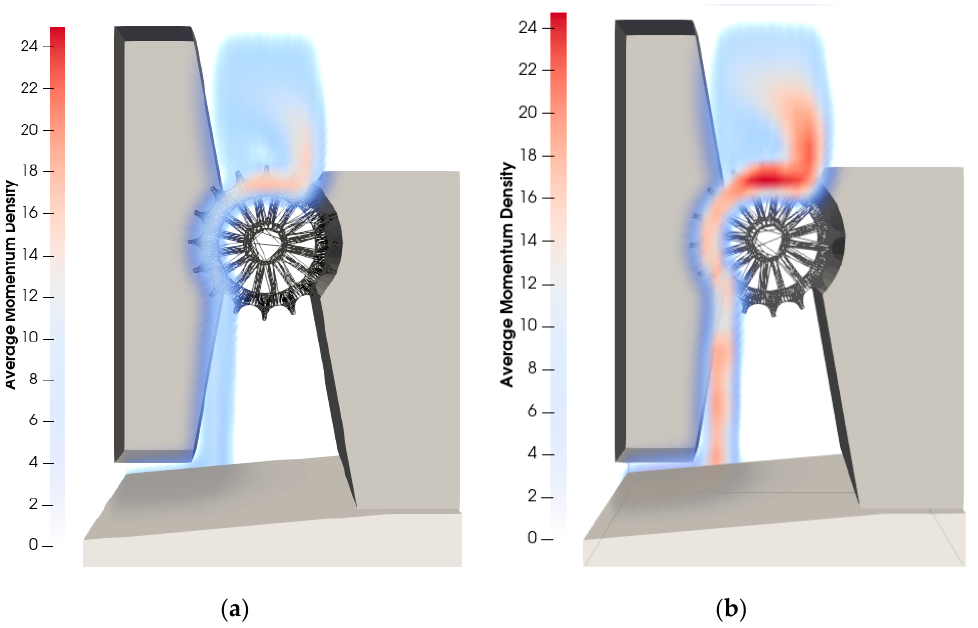
Figure 12. Average momentum density (kg/m 2 ∙ s) for the ( a ) free-flowing and ( b ) cohesive materials. Further, investigating the profiles of the compressive forces in the region around the wheel (Figure 13), the height of the wheel was divided in equal horizontal layers, and the results were normalized against the masses of the particles for each material. It was ob- served that the profiles for both materials followed the same shape, but the cohesive ma- terial had an overall higher reduction rate at the H4 compartment than the free-flowing one. This indicated that the free-flowing material was better packed, which led to a more uniform force distribution.